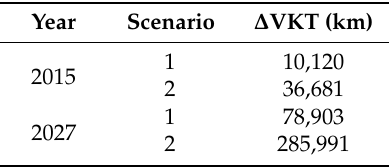
Table 2. Incremental increases in vehicle kilometers of travel from baseline levels.